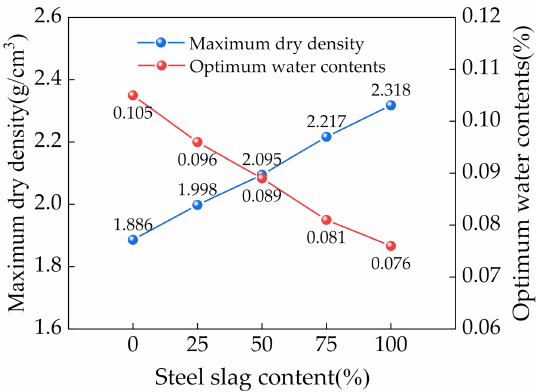
Figure 5. Variation curves of the maximum dry density and optimum moisture content.